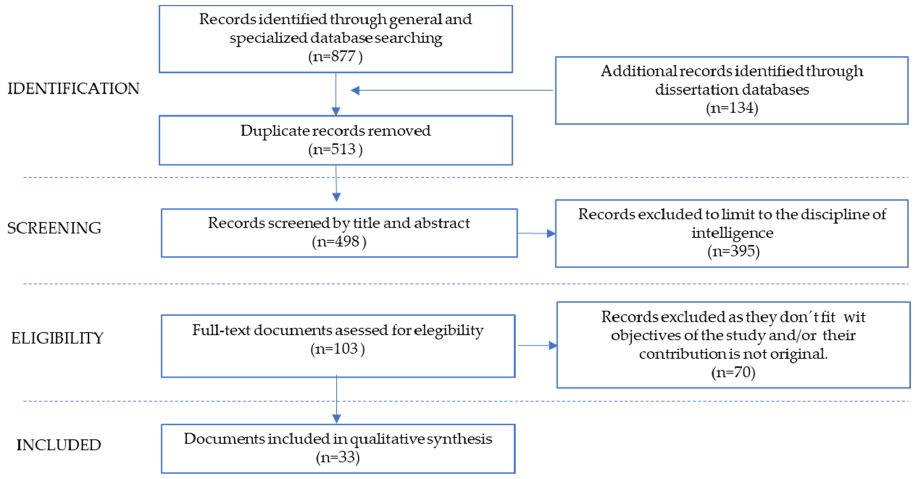
Figure 1. Inclusion decision flowchart.